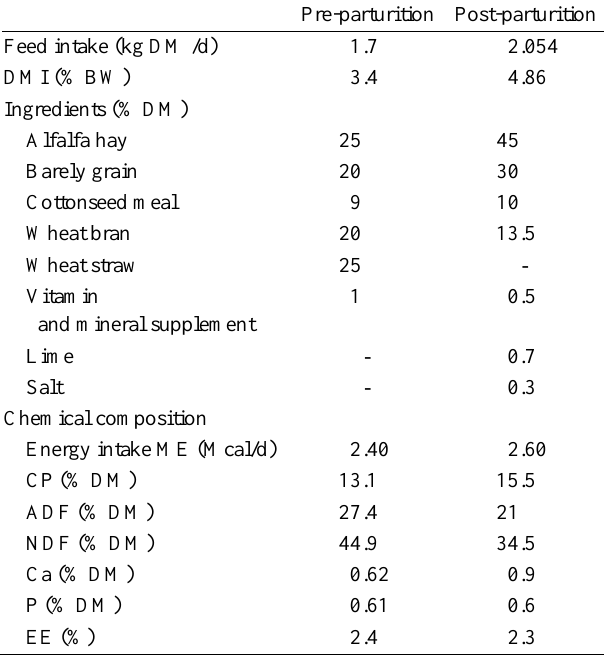
Table 1. Ingredients and chemical composition of the experimental